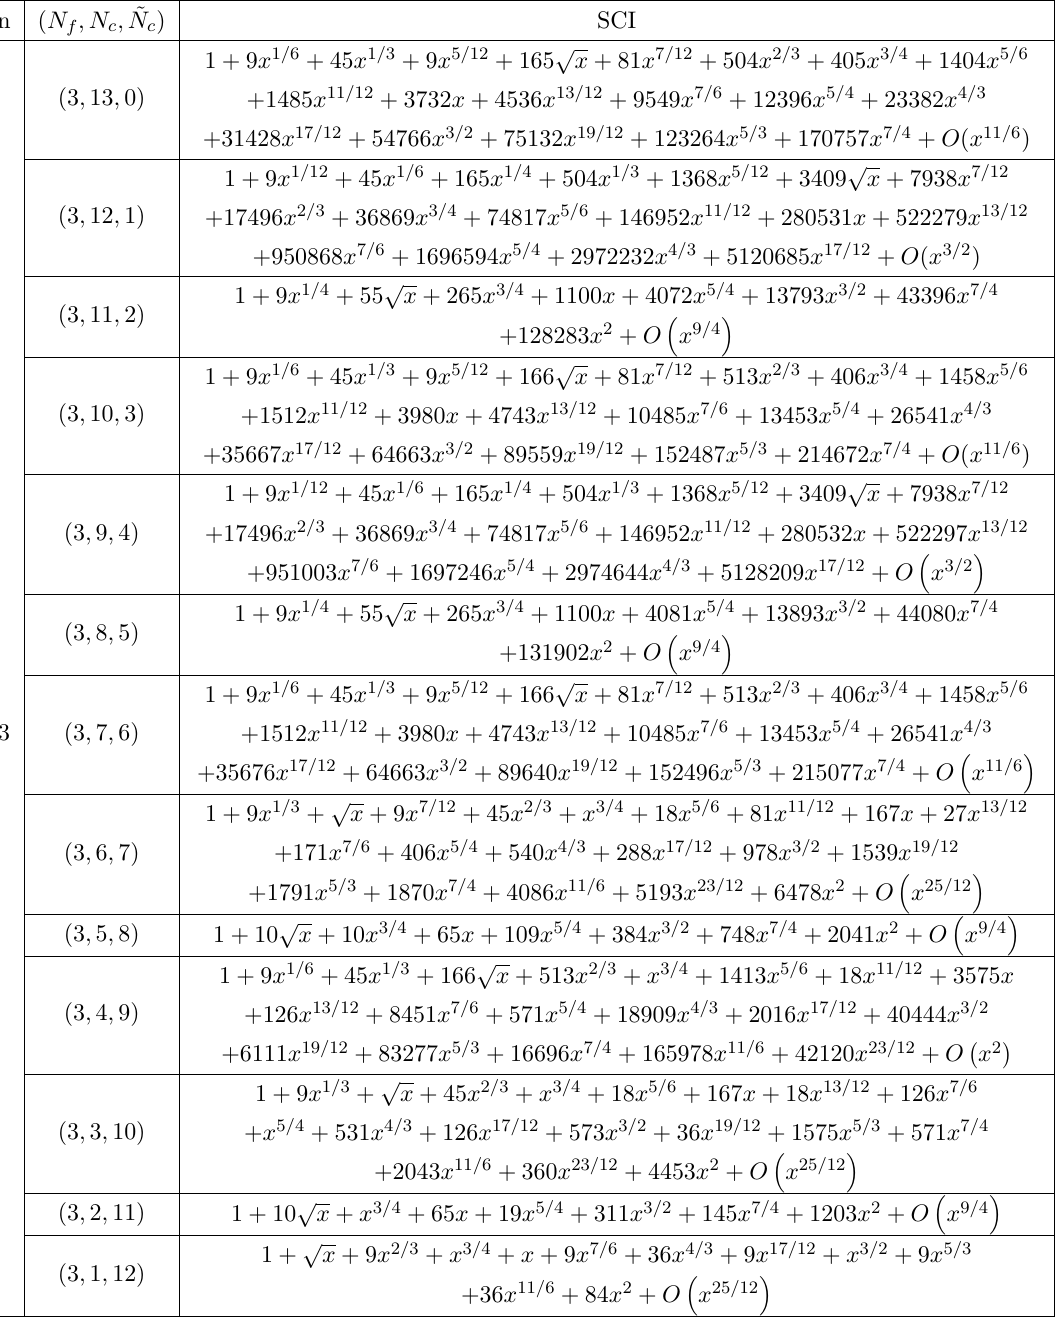
Table 14 . The superconformal index results for the double adjoint theories with ∆ W A = V + Here we list the cases with ( n, N operators with negative conformal dimension are flipped for the expansion of the index.